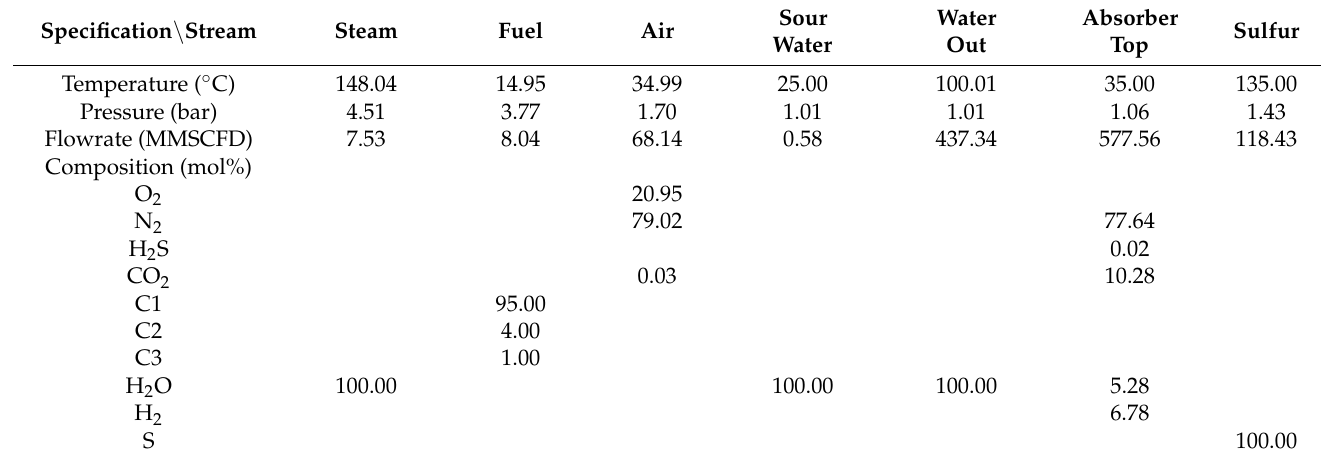
Table 5. SRU and TGT conditions and